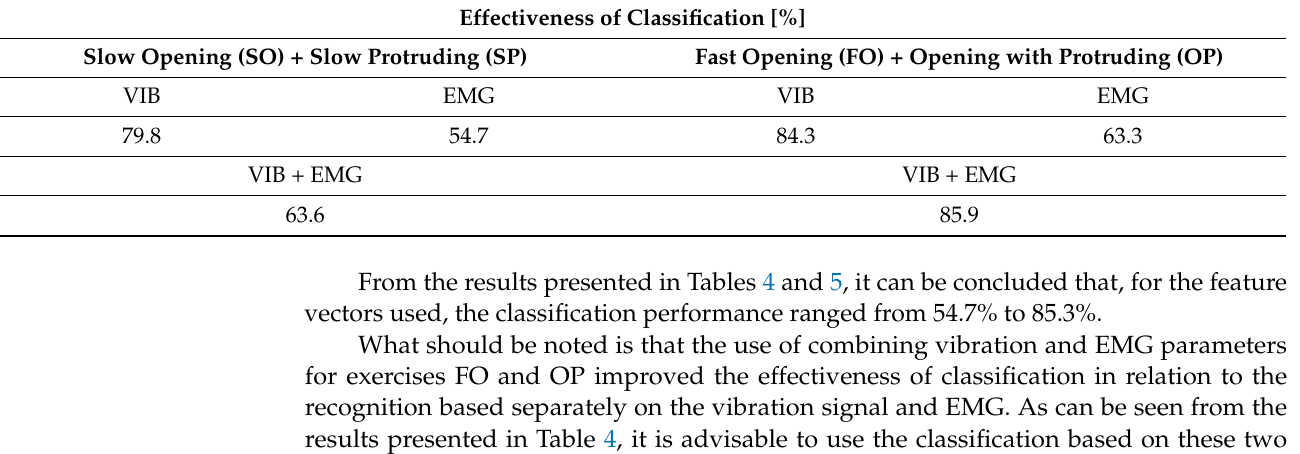
Table 5. Effectiveness of k-NN